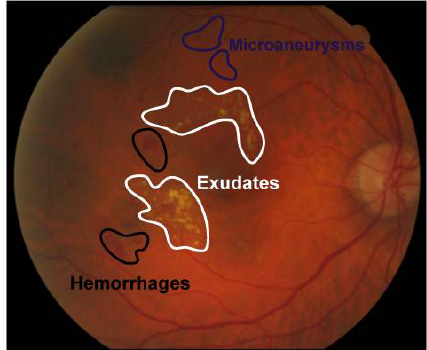
Figure 1: Retinal fundus image